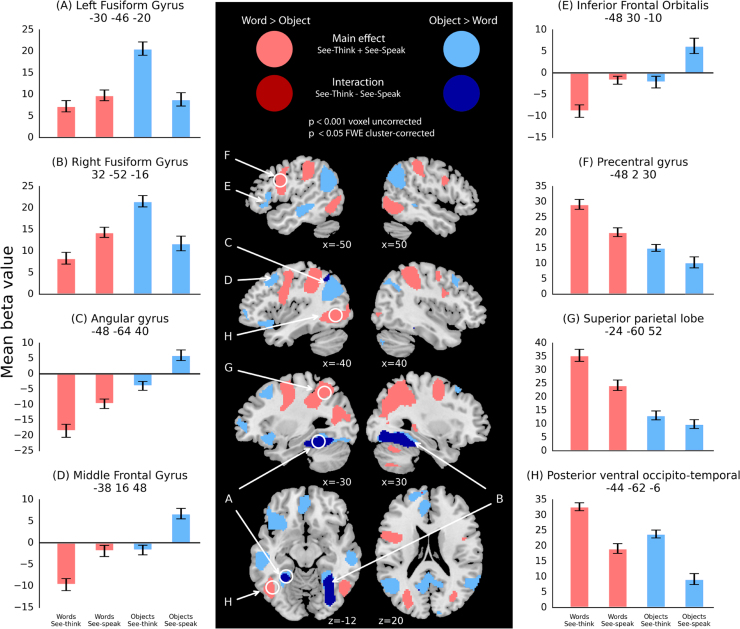
Brain regions showing differential activation for contrasts of interest for the artificial words and objects in see-think and see-speak conditions. Pale red=[words [see-think+see-speak]−objects [see-think+see-speak]], pale blue=[objects [see-think+see-speak]−words [see-think+see-speak]], dark red=[words [see-think − see-speak]−objects [see-think − see-speak]], dark blue=[objects [see-think − see-speak]−words [see-think − see-speak]]. NB: Dark red activation doesn’t reach statistical significance in this panel. Numbered plots show response profiles for contrasts versus the (unmodelled) resting baseline at peak locations labelled in the activation maps. White circles indicate approximate locations of regions of interest defined from the functional localiser (shown in Fig. 3).